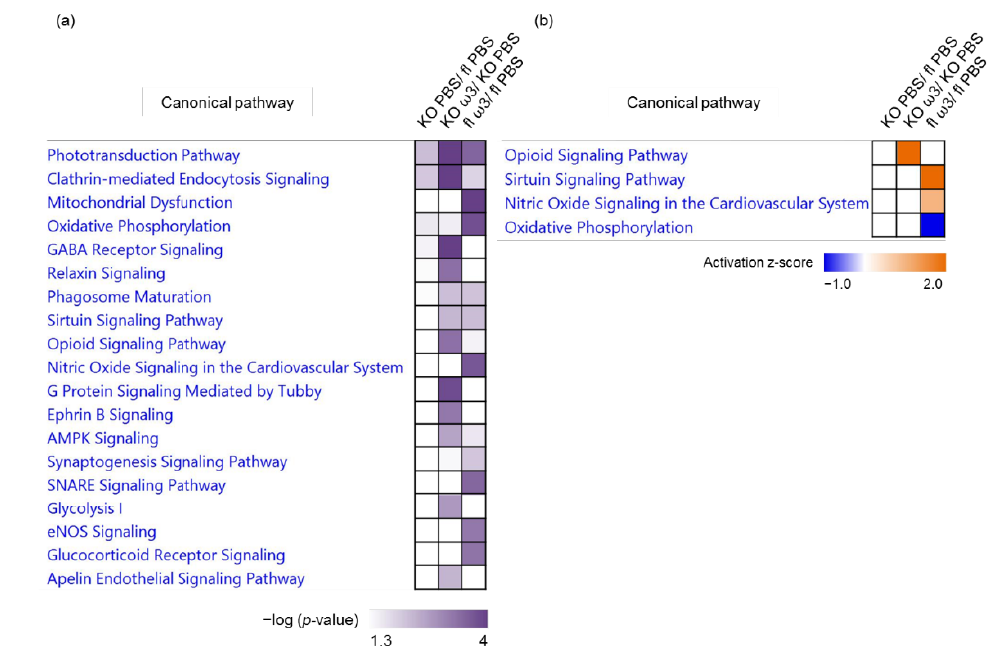
Figure 5. Top significantly affected canonical pathways in the retina. Chart depicts the significantly ( p < 0.05) enriched canonical pathways implicated in the retina, which were determined by p -value overlap between the proteins identified in our datasets and the molecules in the respective pathways, according to ( a ) −log10 ( p- value) and ( b ) activation z-score. Blue indicates negative and orange indicates positive regulation based on the activation z-scores for canonical pathway comparison between the different groups and treatment paradigms.